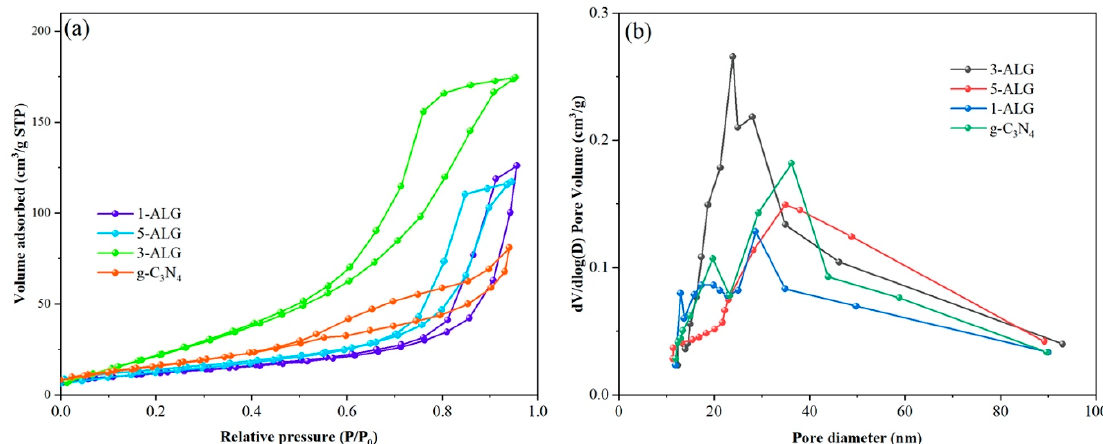
Figure 5. Nitrogen adsorption-desorption isotherms ( a ) and pore distribution curves ( b ) of bare g-C 3 N 4 and 1-ALG, 3-ALG, and 5-ALG. Table 1. The average pore sizes and specific surface areas of g-C 3 N 4 , 1-ALG, 3-ALG and 5-ALG.